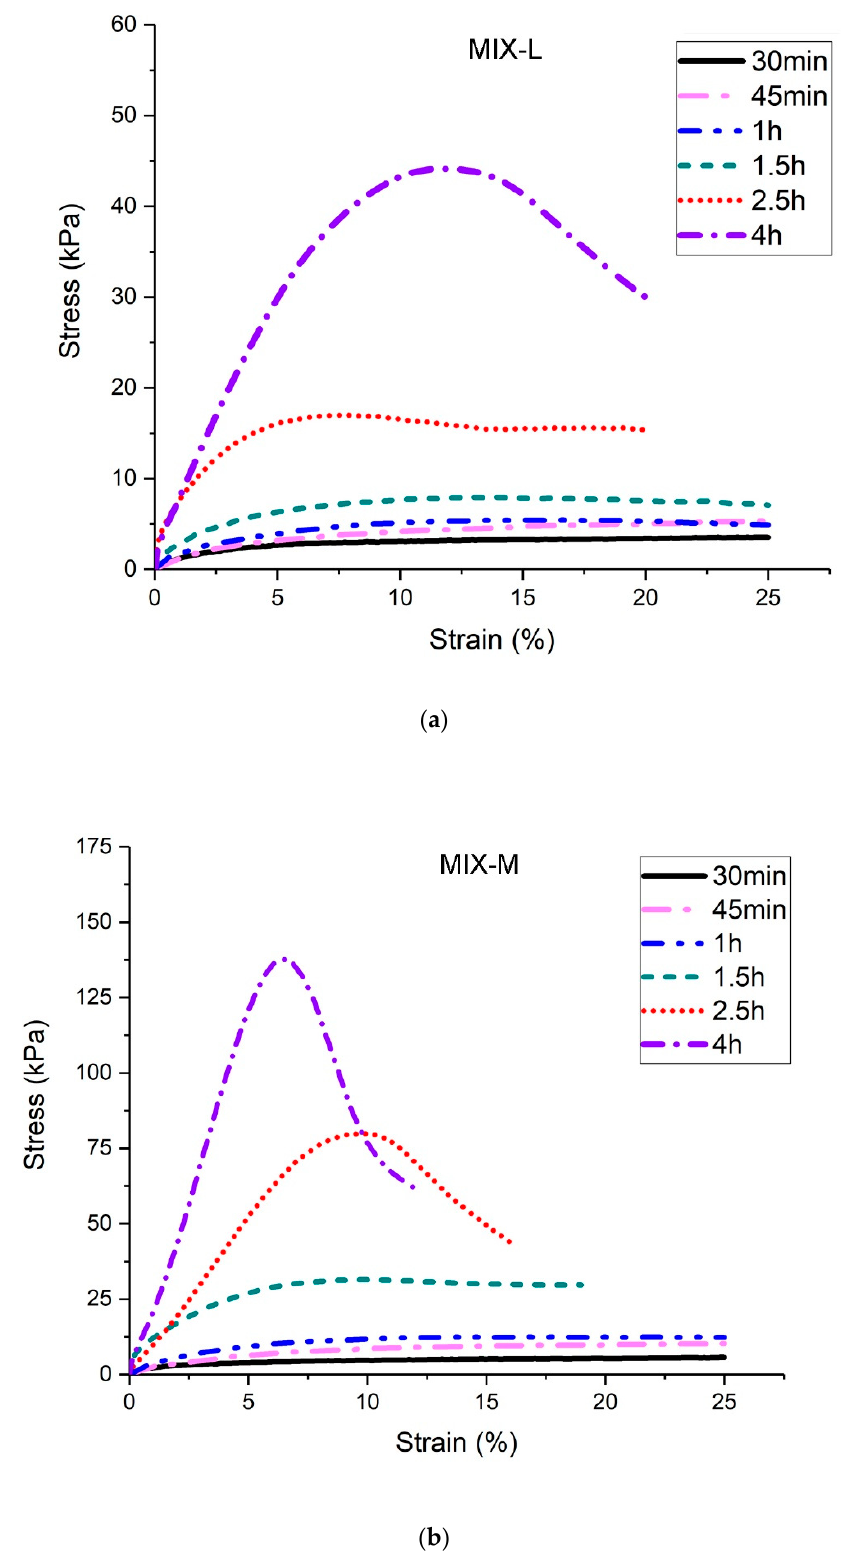
Figure 9. Mixture MIX-H samples in the green strength test. Photographs of demolded samples at different ages (first row); Photographs of damaged samples at different ages (second